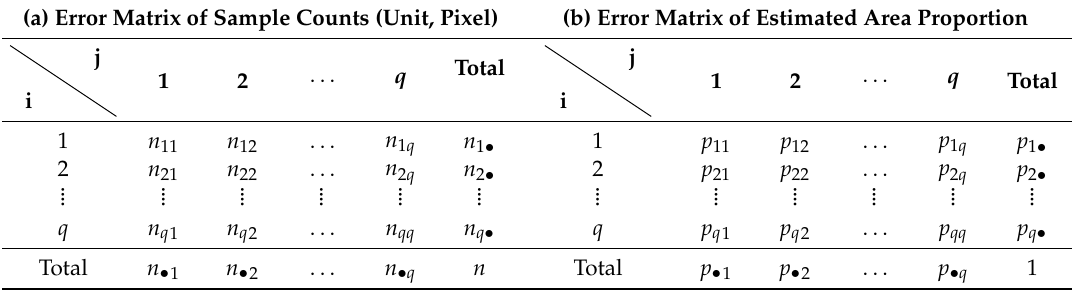
Table 1. Error confusion matrix of sample counts and estimated area proportion. (a) Error Matrix of Sample Counts (Unit, Pixel) (b) Error Matrix of Estimated Area Proportion